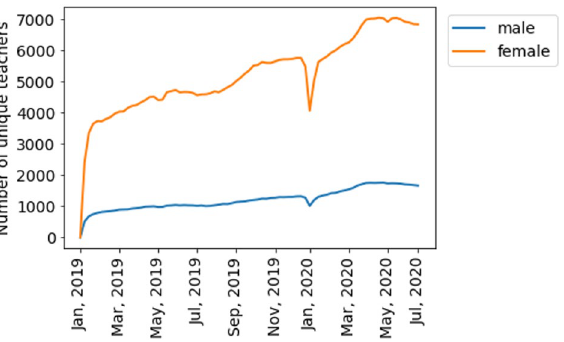
Figure 7. The dynamics of the number of unique teachers (men and women) during the observation period.